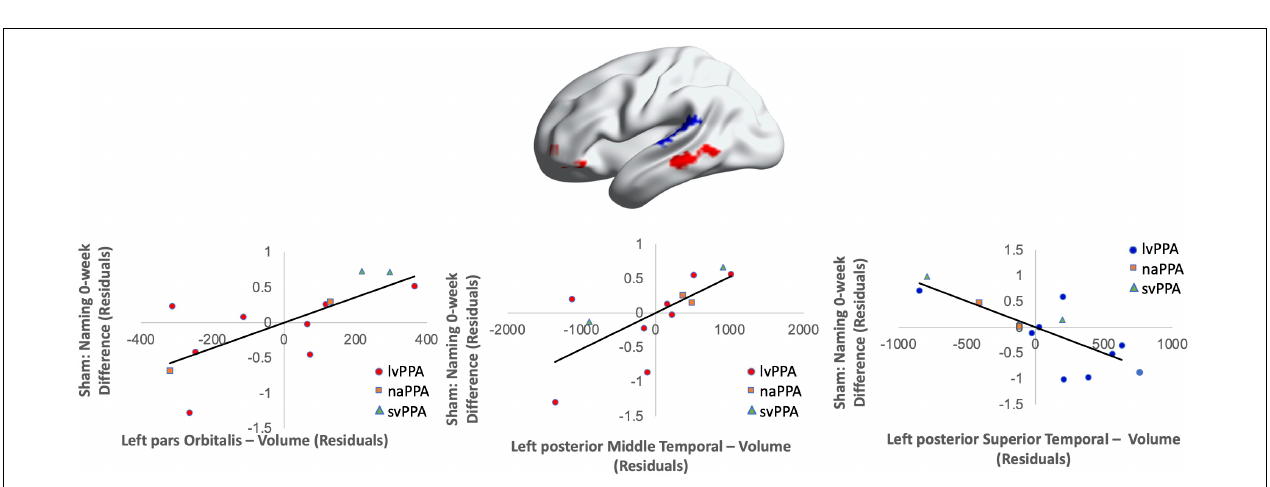
FIGURE 6 | Greater baseline cortical volume of the IFGtr (highlighted in red), MTG (highlighted in red), and lower volume of aSTG and pSTG (highlighted in blue) predicted naming gains in the active condition at 6-week post-intervention (red = greater thickness; blue = lower thickness; R 2 = 0.74).